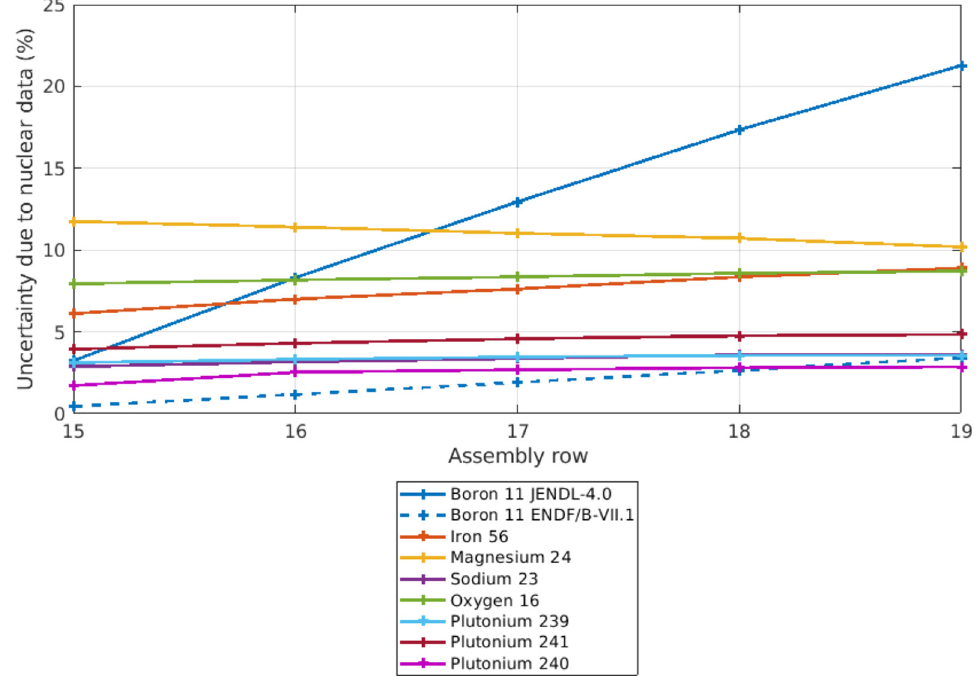
Fig. 34. Nuclear data uncertainty by isotope on the production of tritium in the neutron shielding assemblies.